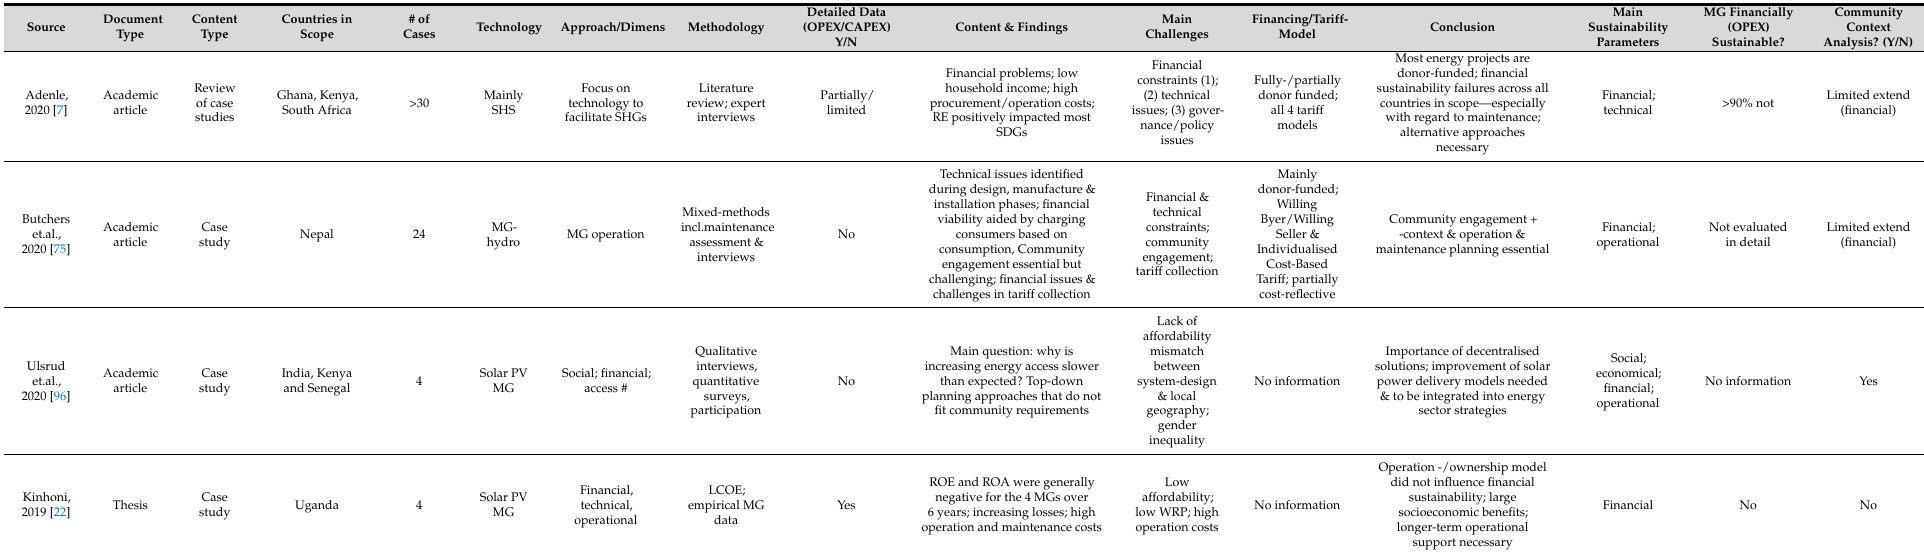
Table A1. Integrated, systematic literature review: categories and